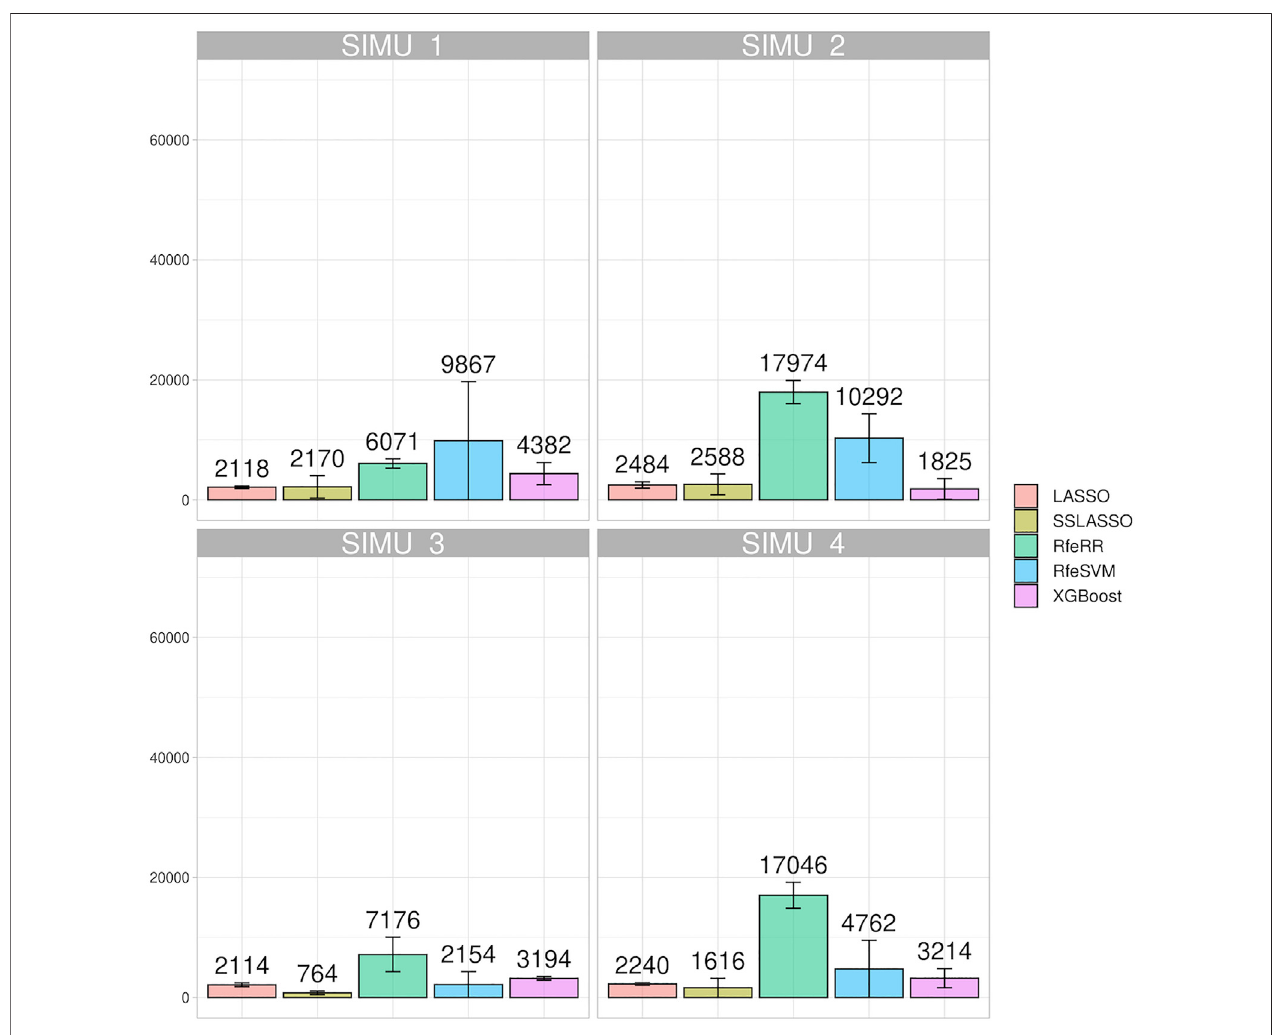
FIGURE 4 | Bar plot representing the number of SNPs retained by each algorithm on the four simulated population; error bars represent standard